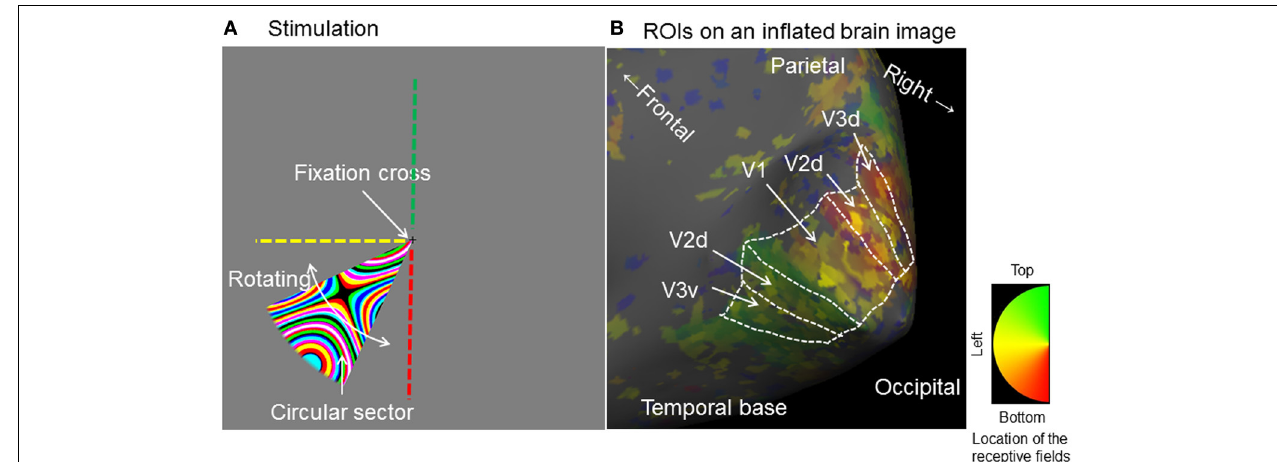
FIGURE 2 | Stimulation for obtaining retinotopic maps and charting region of interest on an inflated brain image for a typical single subject. (A) Stimulus: A circular sector (central angle 40 ◦ ) sustaining 8 ◦ and rotated in either a clockwise or anticlockwise direction for eight cycles at an angular velocity of 61.2 seconds per cycle. The sector was filled with a dynamically expanding colored ripple pattern. Green, yellow and red